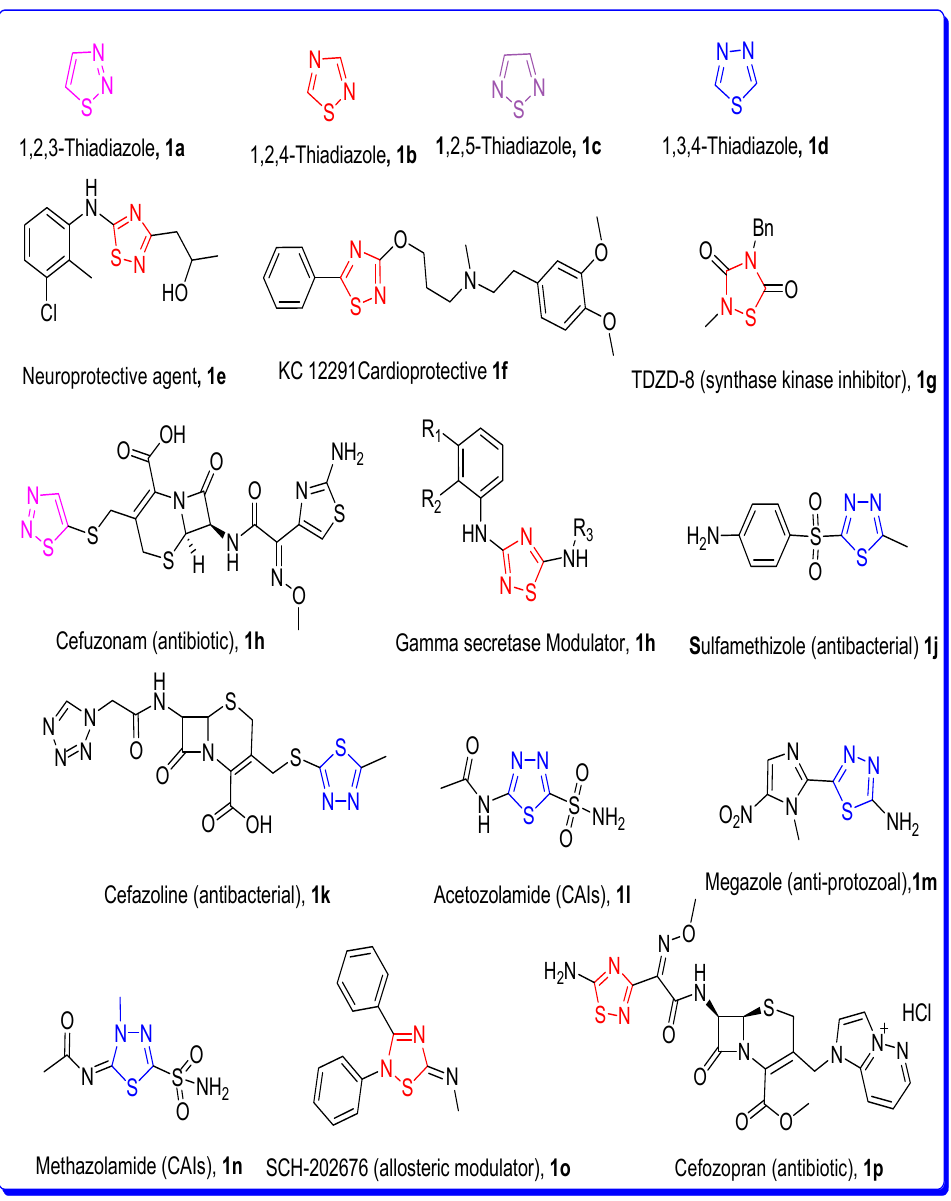
Figure 4. Bioactive thiadiazole scaffolds.